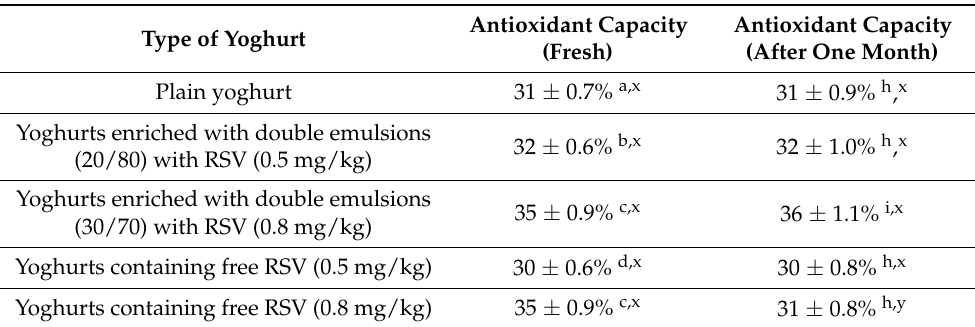
Table 2. Antioxidant capacity of samples prepared fresh and after one month of storage: plain yo- ghurts, yoghurts containing free RSV (0.5 mg/kg and 0.8 mg/kg) and yoghurts containing emulsions with RSV (0.5 mg/kg and 0.8